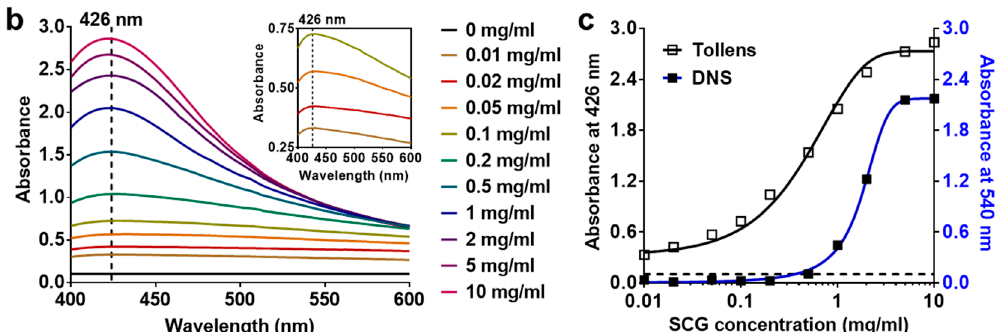
Figure 5. ( a ) Color development of the reaction as a function of concentration of debranched SCGs through modified Tollens’ reaction (top) and 3,5-dinitrosalicylic acid (DNS) reaction (bottom). ( b ) UV-vis absorption spectra showing the characteristic absorption peaks of AgNPs regardless of the concentration of debranched SCGs. The inset is a magnified view of the absorption spectra of AgNPs formed at the lower concentrations of SCGs. ( c ) Calibration curves for the quantitative determination of debranched SCGs through the modified Tollens’ reaction (hollow square) and DNS method (filled square). The dotted line represents the SPR absorption spectrum of AgNPs formed without SCGs (control). A curve was fitted for nonlinear regression using a sigmoidal function.